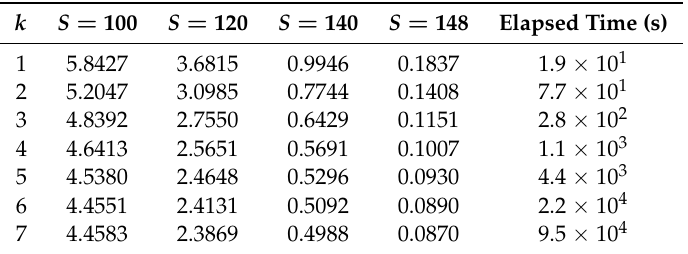
Table 4. V ( S ,0,0 ) evaluated by FD1 at S = 100,120,140,148, with ∆ S = 1.